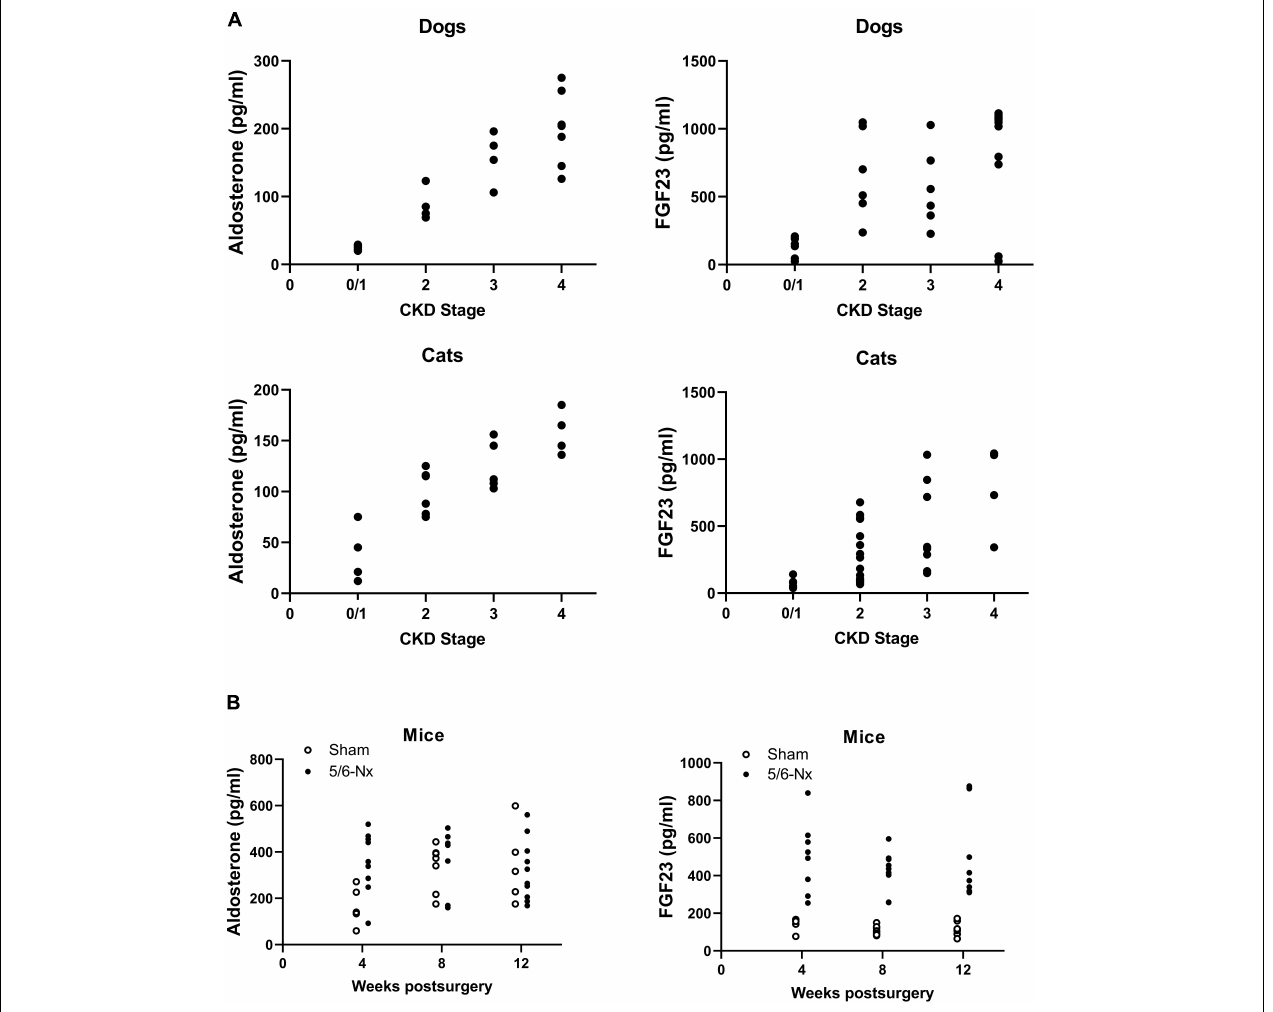
FIGURE 1 | Stage-dependent increase in aldosterone and circulating FGF23 in clinical and experimental CKD. (A) , Stage-dependent increase in aldosterone and circulating intact FGF23 in cats and dogs with CKD. (B) , Aldosterone and intact FGF23 serum levels in Sham and 5/6-Nx mice as an experimental CKD model, 4, 8, and 12 weeks